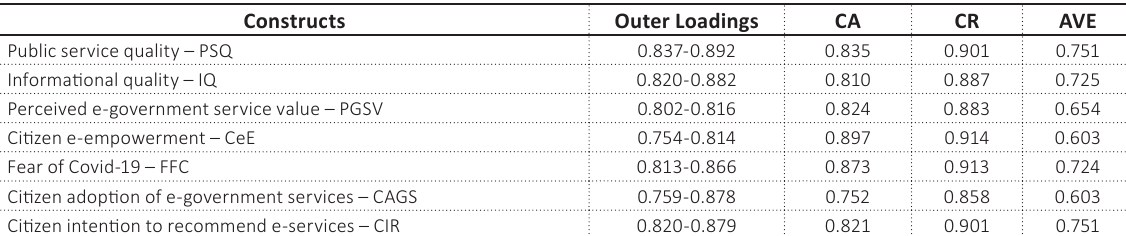
Table 2. Internal consistency reliability and convergent